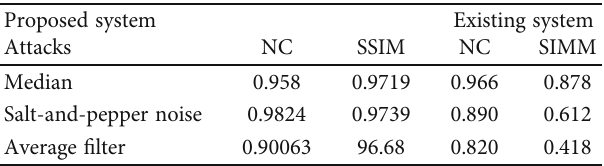
Table 4: Comparison results of the proposed system against an existing study [50].